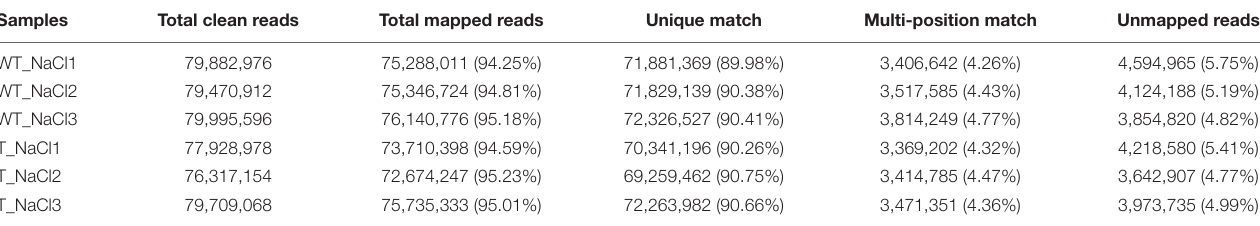
FIGURE 4 | Analysis of oxidative damage extent in transgenic wheat lines compared to WT plants under salt stress conditions. MDA contents in leaves (A) , leaf sheaths (B) , and roots (C) . Mean values and deviations were calculated from three independent biological experiments. ∗ p ≤ 0.05, ∗∗ p ≤ 0.01, and ∗∗∗ p ≤ 0.001 indicate significance in transgenic wheat lines relative to WT. (D) H 2 O 2 accumulation level detected by DAB histochemical staining. (E) H 2 O 2 content was determined in the roots of the 10-day-old wheat seedlings using an H 2 O 2 content assay kit. TL9 and TL30, the transgenic wheat lines; WT, wild type. TABLE 1 | Summary of reads mapping to reference